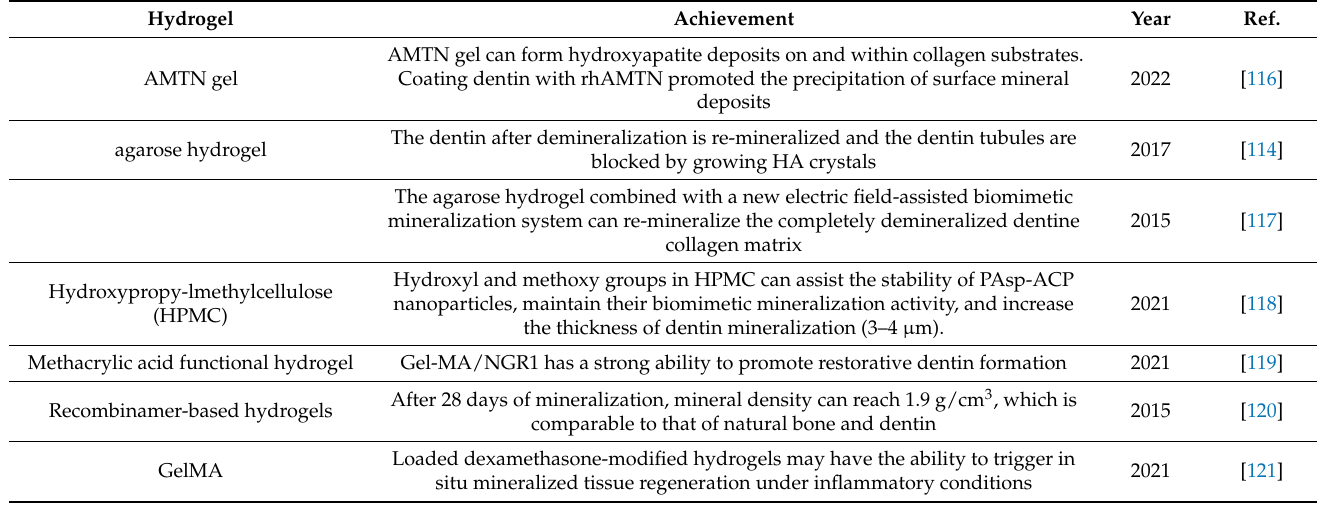
Table 5. Application of hydrogel in mineralization of